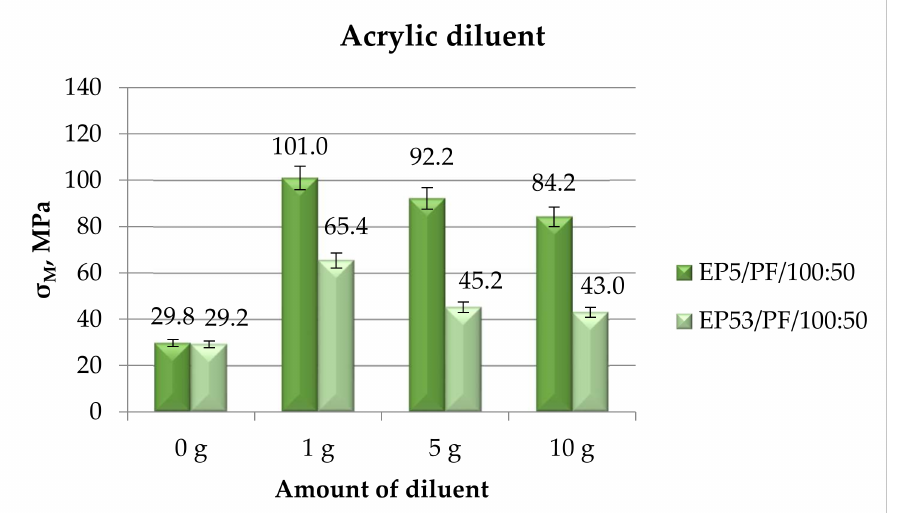
Figure 13. Compressive strength calculated for Epidian 5 and Epidian 53 epoxy compounds as a function of the amount of acrylic diluent.